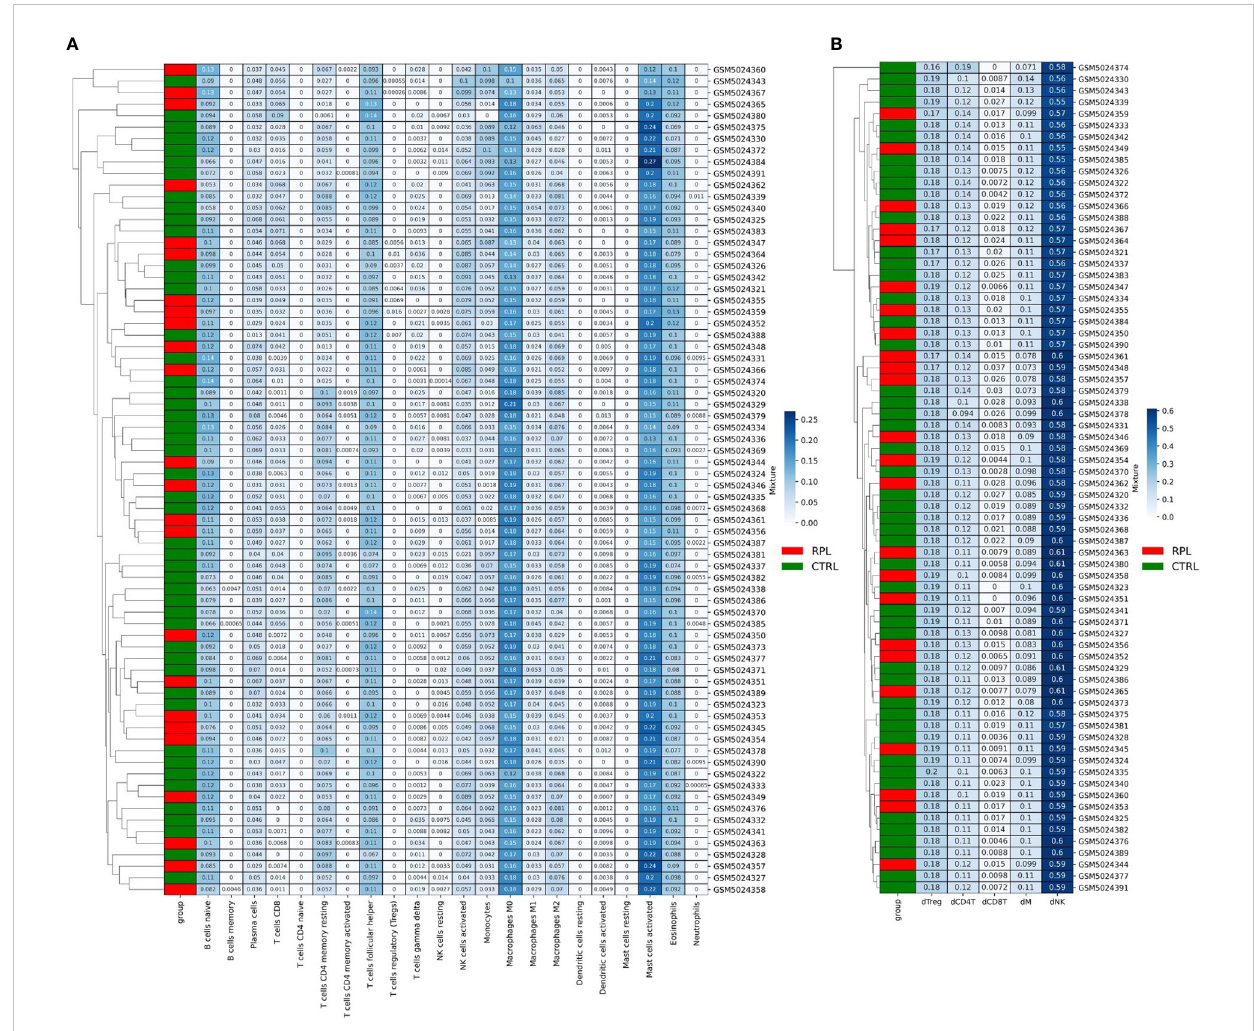
procedure as indicated in the CIBERSORTx manual. The new RPL signature matrix was used to perform the deconvolution